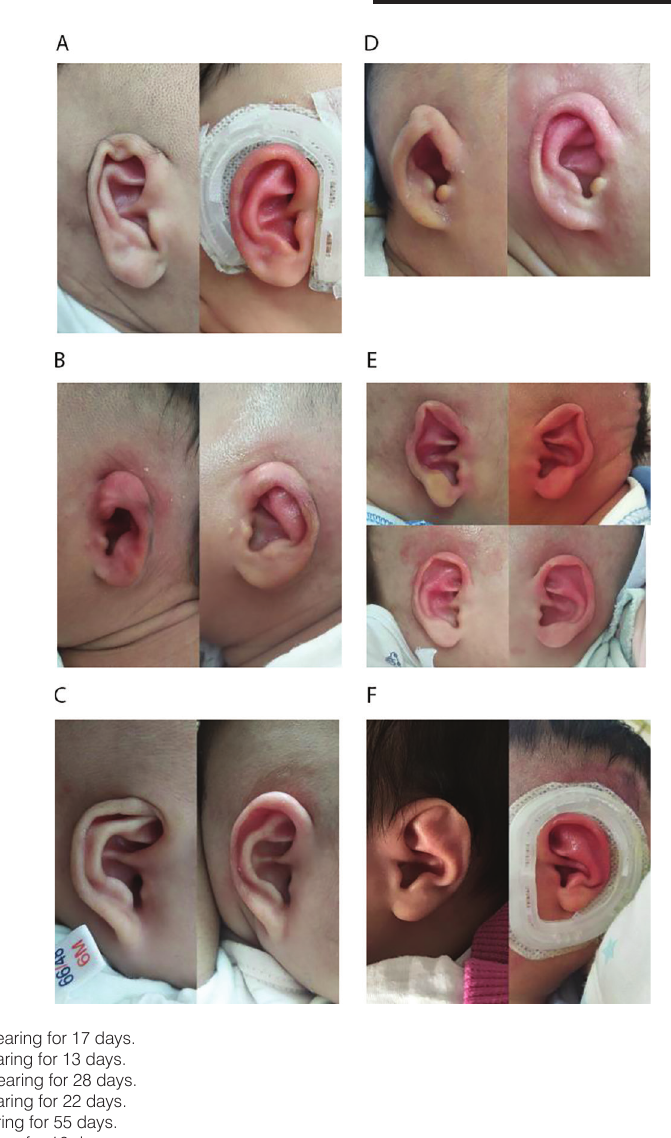
Figure 1. Treatment example of EarWell Infant Ear Correction